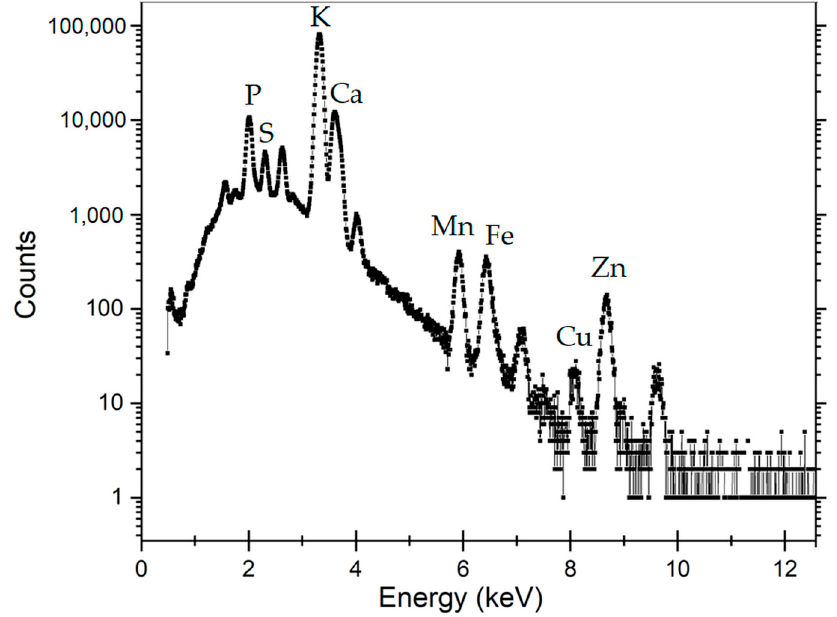
Figure 7. PIXE spectrum for ‘Otilia’ plasma-treated wheat seed.